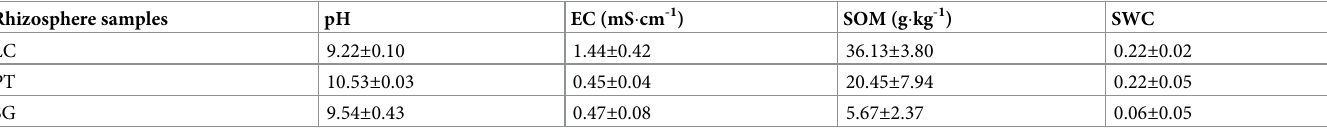
EC—electrical conductivity; SOM—soil organic matter; SWC—soil water content. Values are means ± standard deviation. Different lowercase letters into each column are significantly different (Tukey’s test, P <